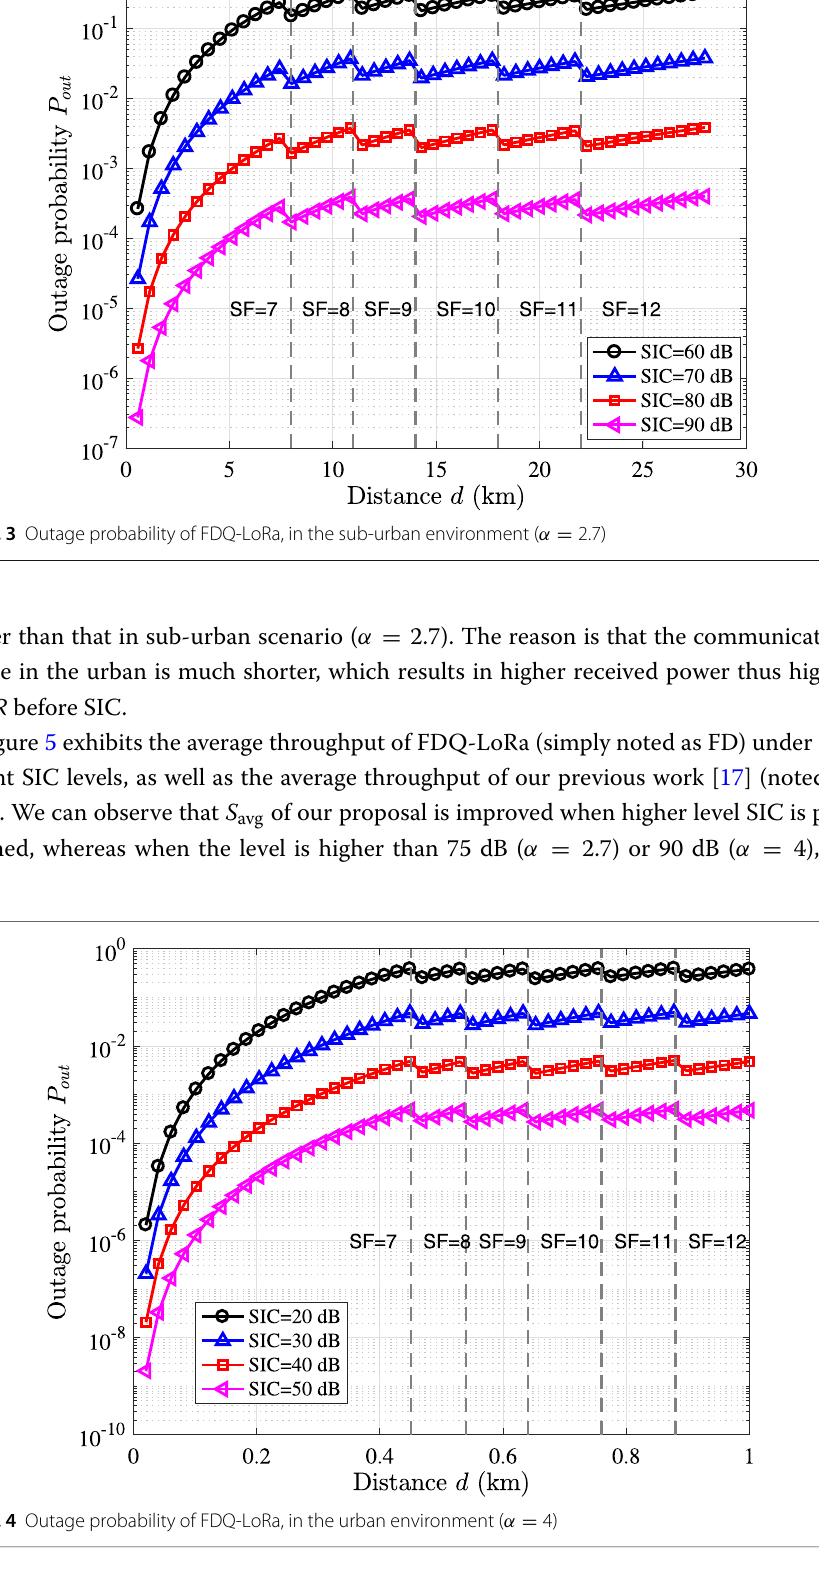
Fig. 4 Outage probability of FDQ-LoRa, in the urban environment ( α =